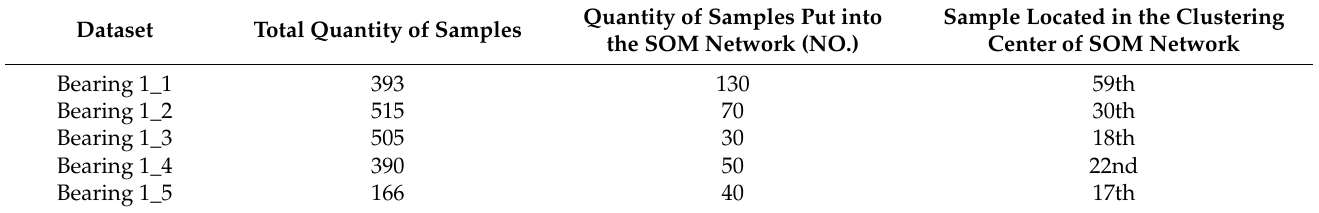
Figure 6. Changing rates of RMS. ( a ) Bearing 1_1, ( b ) Bearing 1_2, ( c ) Bearing 1_3, ( d ) Bearing 1_4, ( e ) Bearing 1_5. Table 3. Results of OHS selection.